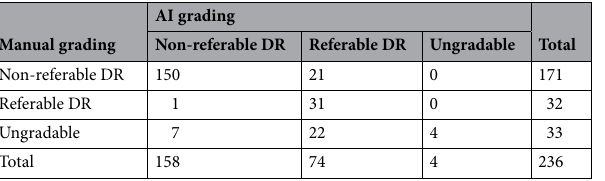
Table 3. Cross tabulation results between artificial intelligence system and manual grading. DR = diabetic retinopathy.